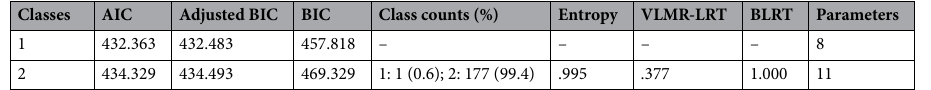
Table 3. The model fit information for the GMM models for stress (N = 178). GMM Growth Mixture Model, AIC Akaike Information Criterion, BIC Bayesian Information Criterion, VLMR-LRT Vuong-Lo-Mendell- Rubin Likelihood Ratio Test, BLRT Bootstrap Likelihood Ratio Test.